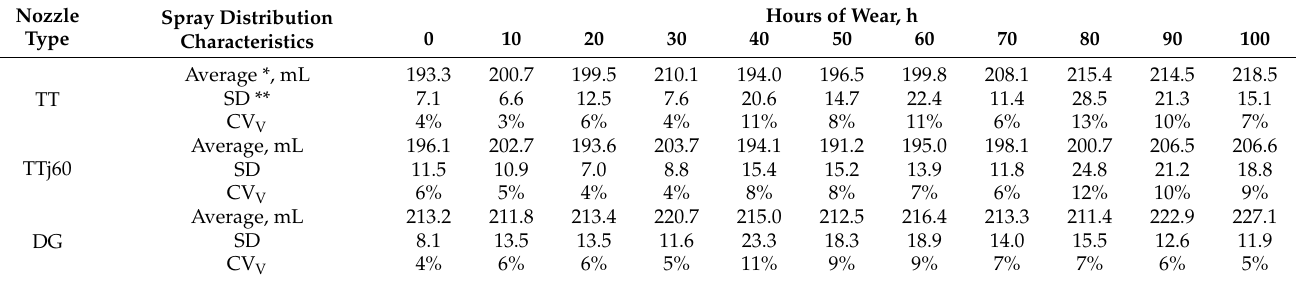
Table 4. The spray distribution characteristics at different wear intervals for the TT, TTj60, and DG